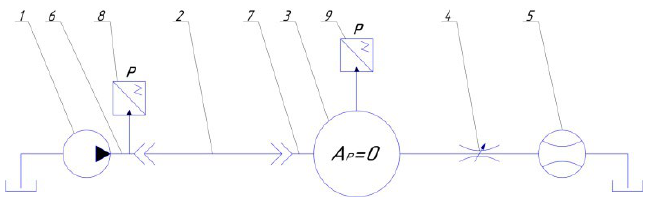
Figure 13. ISO 1219 scheme of the bench system implementing the inertial load impedance at the liquid output from the pump: 1—test pump; 2—line; 3—cavity of “infinite” volume; 4—load throttle; 5—flow sensor, 6 and 7—connecting fittings; 8 and 9—pressure sensors at the line input and in the cavity, respectively.